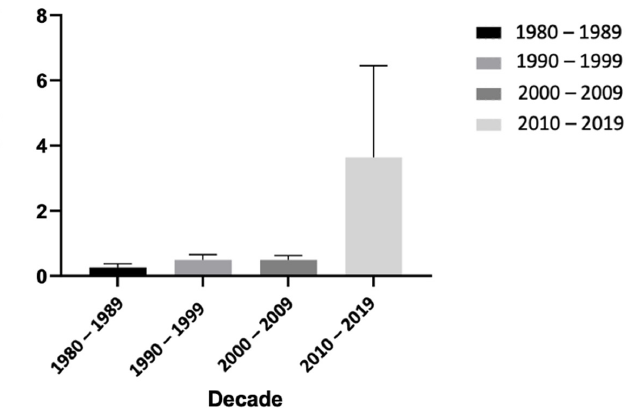
Figure 4. The mean and SEM of the economic loss and damage sustained in the Caribbean by TC from 1980–2019.